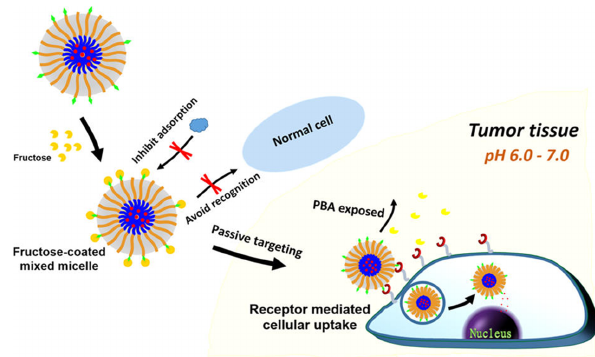
Figure 14: Illustration of pH-activated targeting drug delivery system based on selective binding with PBA. Reprinted with permission from [64]. Copyright 2016, American Chemical